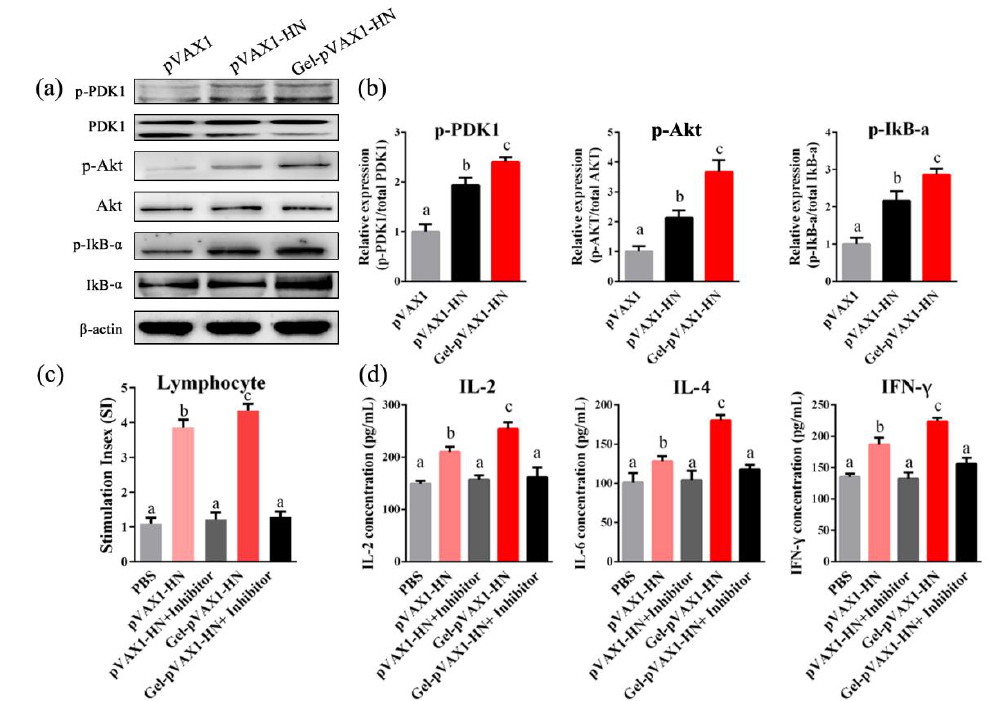
Figure 8. PLGA-PEG-PLGA vaccine delivery system activated the PI3K/Akt pathway in lymphocytes. ( a ) Lymphocytes isolated from the immune chickens’ blood and the protein levels of the PI3K/Akt pathway were detected by a western blot analysis. ( b ) Relative protein expressions. The effects of the